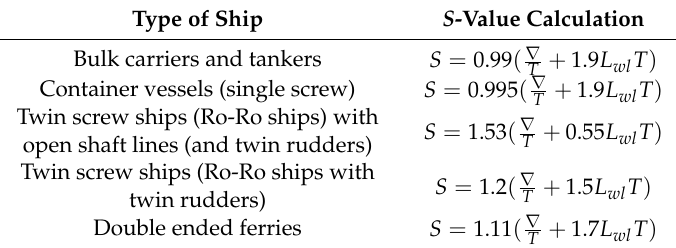
Table 1. Wetted surface of hull reference